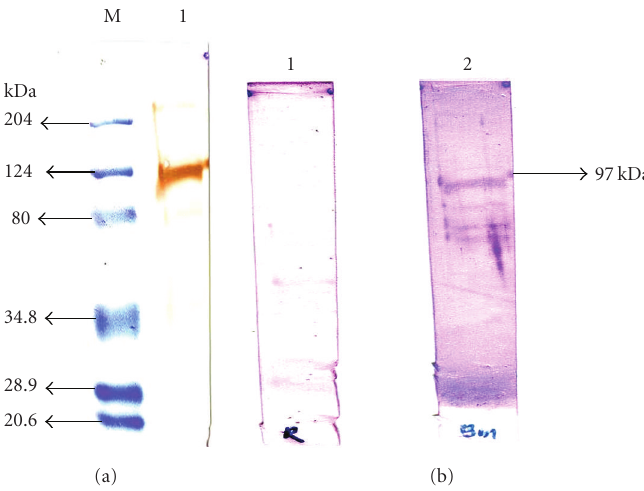
Figure 3: Immunoblot showing reaction of rHaa86 with (a) mouse antipenta histidine antibody; lane 1, strong reaction with rHaa86 and lane M, molecular weight marker and (b) with anti-Bm86 antibody; lane 1, no reaction with normal sera and lane 2, reaction with anti- H. a. anatolicum larval antibody. Table 1: Feeding and reproductive performances of ticks fed on immunized and control calves. Experimental calves